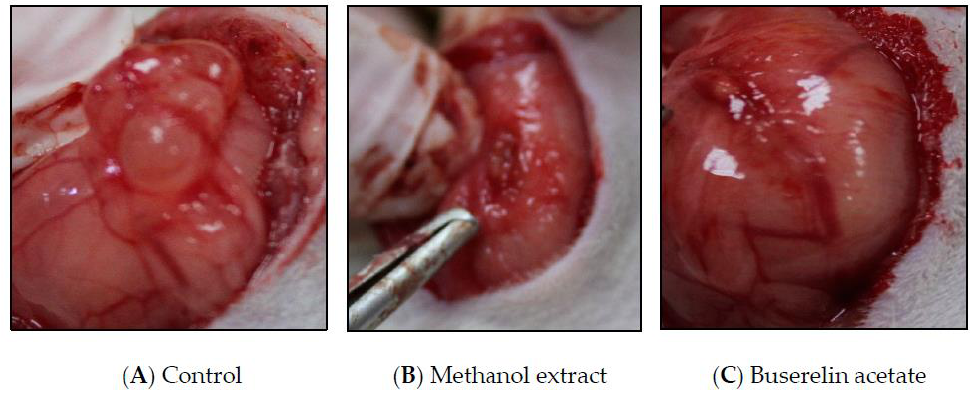
Figure 3. Post-treatment endometriotic implant images of control, methanol extract, and buserelin acetate.